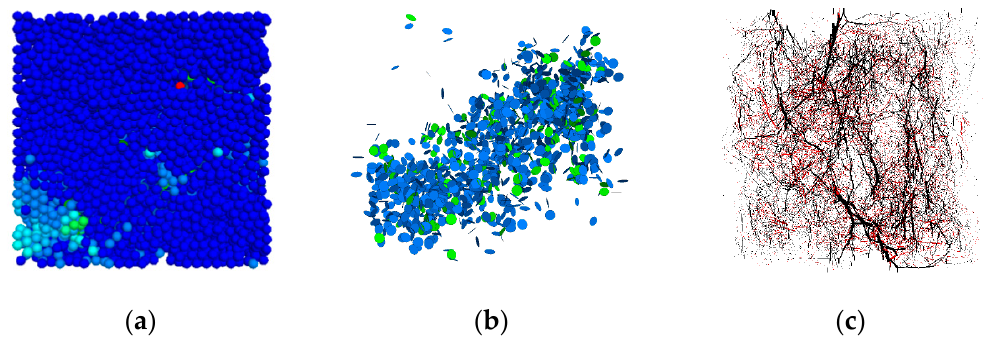
Figure 27. The crack development inside the model of the foamed concrete with a density of 600 kg/m 3 at a loading rate of 0.6 mm/min. ( a ) model failure mode; ( b ) crack development; ( c ) force-chain distribution.